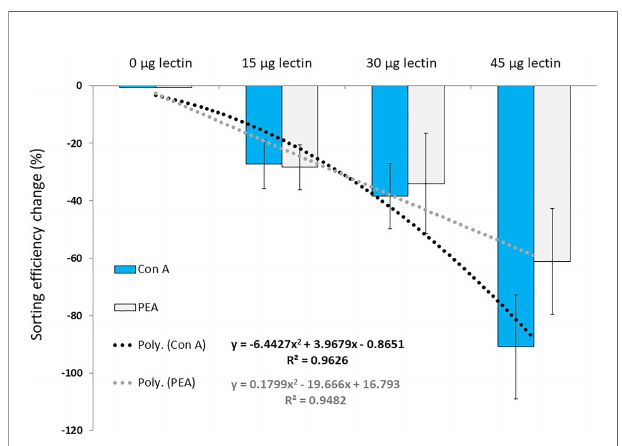
FIGURE 3 | Percent change in sorting ef fi ciency (mean ± standard deviation, n = 12 per data point) for microalgae treated with different quantities of lectins as compared to controls (0 µg lectin). Dashed lines and equations represent the best fi tting models for each lectin.